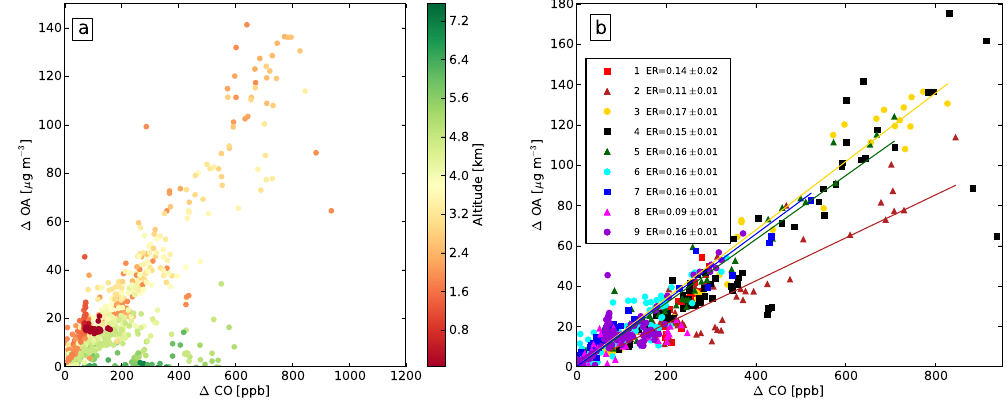
Figure 7. Enhancement ratios of (cid:49) OA /(cid:49) CO ratios for Flight b622. (a) is coloured by altitude showing potential aerosol washout in the high-altitude plume (>4.6km). (b) shows the ERs (enhancement ratios) separated by flight transect showing individual enhancement ratios of between 0.09 and 0.17 ± 0.01µgm − 3 ppb − 1 with generally high correlation coefficients ( R 2 >0.7) for the majority. The data points collected at altitudes greater than 4.6km have been removed (as per a ).